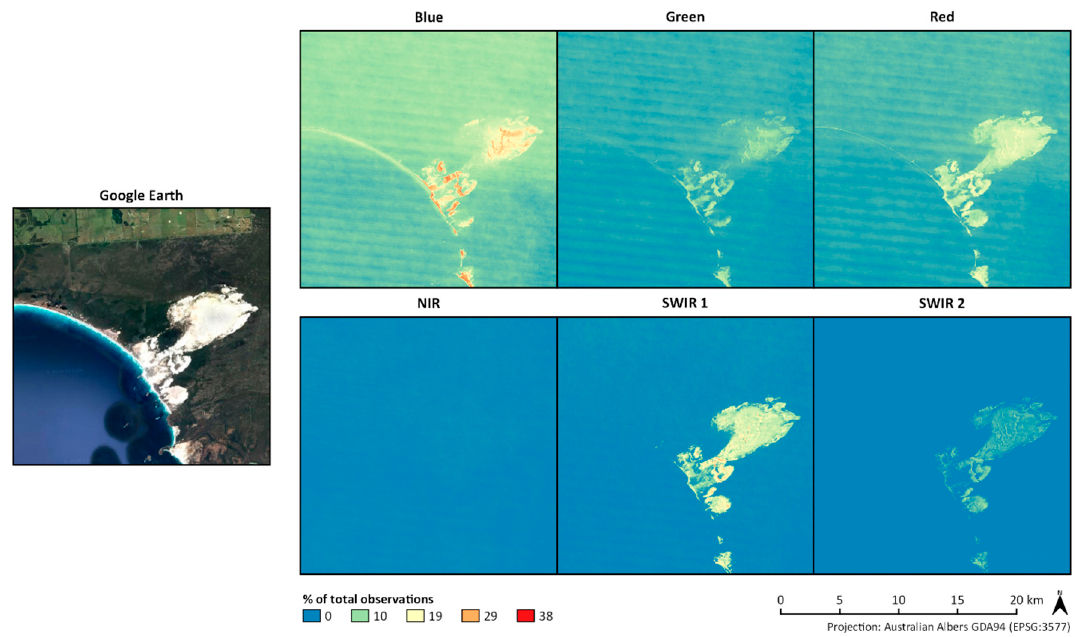
Figure 7. High-resolution imagery (Google, CNES/Airbus, TerraMetrics, DigitalGlobe), saturation flags in the visible, NIR, and SWIR bands in percent of total observations; Cape Arid, WA.